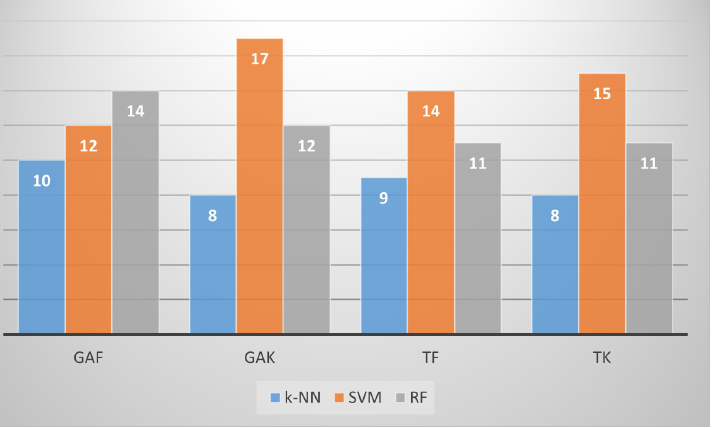
Figure 6. Performance rate (represented in the y axis) of each PPFS method using each classifier for all the